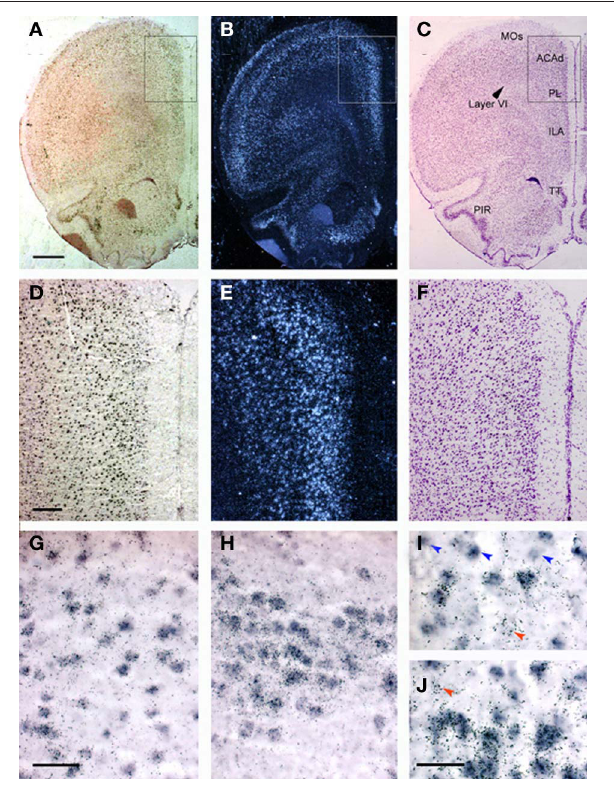
FIGURE 1 | Localization of 5-HT 1A and 5-HT 2A receptor mRNAs in the rat PFC using double in situ hybridization histochemistry. (A–C) Coronal sections of rat PFC showing a large number of cells expressing (A) 5-HT 1A receptors (Dig-labeled oligonucleotides) or (B) 5-HT 2A receptors (dark field; 33P-labeled oligonucleotides); (C) an adjacent Nissl-stained section. Note the abundant presence of cells expressing both receptors in layers II–V, as well as in piriform cortex (PIR) and tenia tecta (TT). (D–F) Enlargements of the marked area in panels (A–C) . (D,E) Show the presence of a large number of cells containing 5-HT 1A and 5-HT 2A receptor transcripts in cingulate (ACAd) and prelimbic (PL) cortex. Cells in deep layers (VI) express preferentially 5-HT 1A receptor mRNA. (G–J) Individual cells expressing both receptor transcripts. Occasional cell profiles containing only 5-HT 1A (blue arrowheads) or 5-HT 2A receptor mRNAs (red arrowheads) were seen in the infralimbic cortex (G,I) , piriform cortex (H) and taenia tecta (J) . Bar size